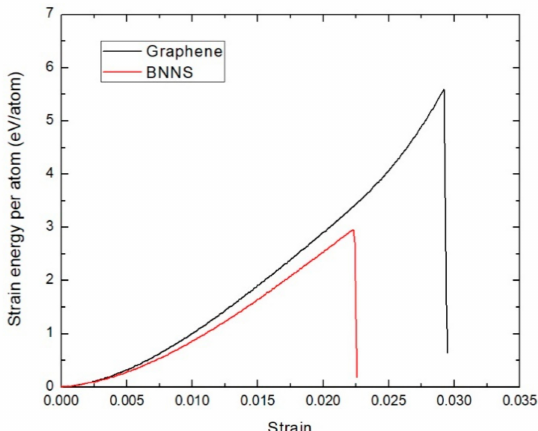
Figure 4. Force–strain plot of graphene and boron nitride nanosheet components in the PE nanocomposites at 300